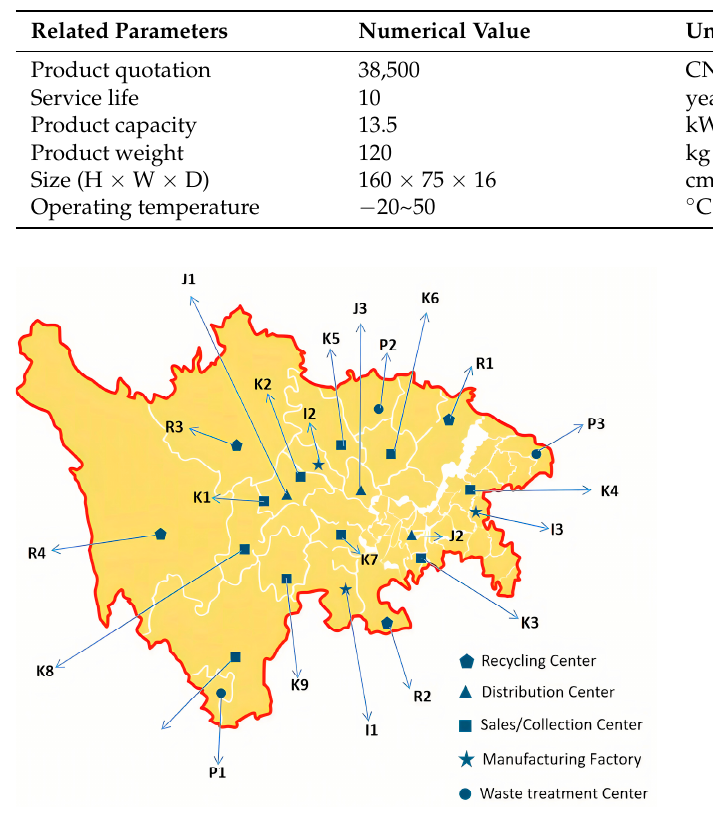
Figure 5. Distribution of alternative processing centers.